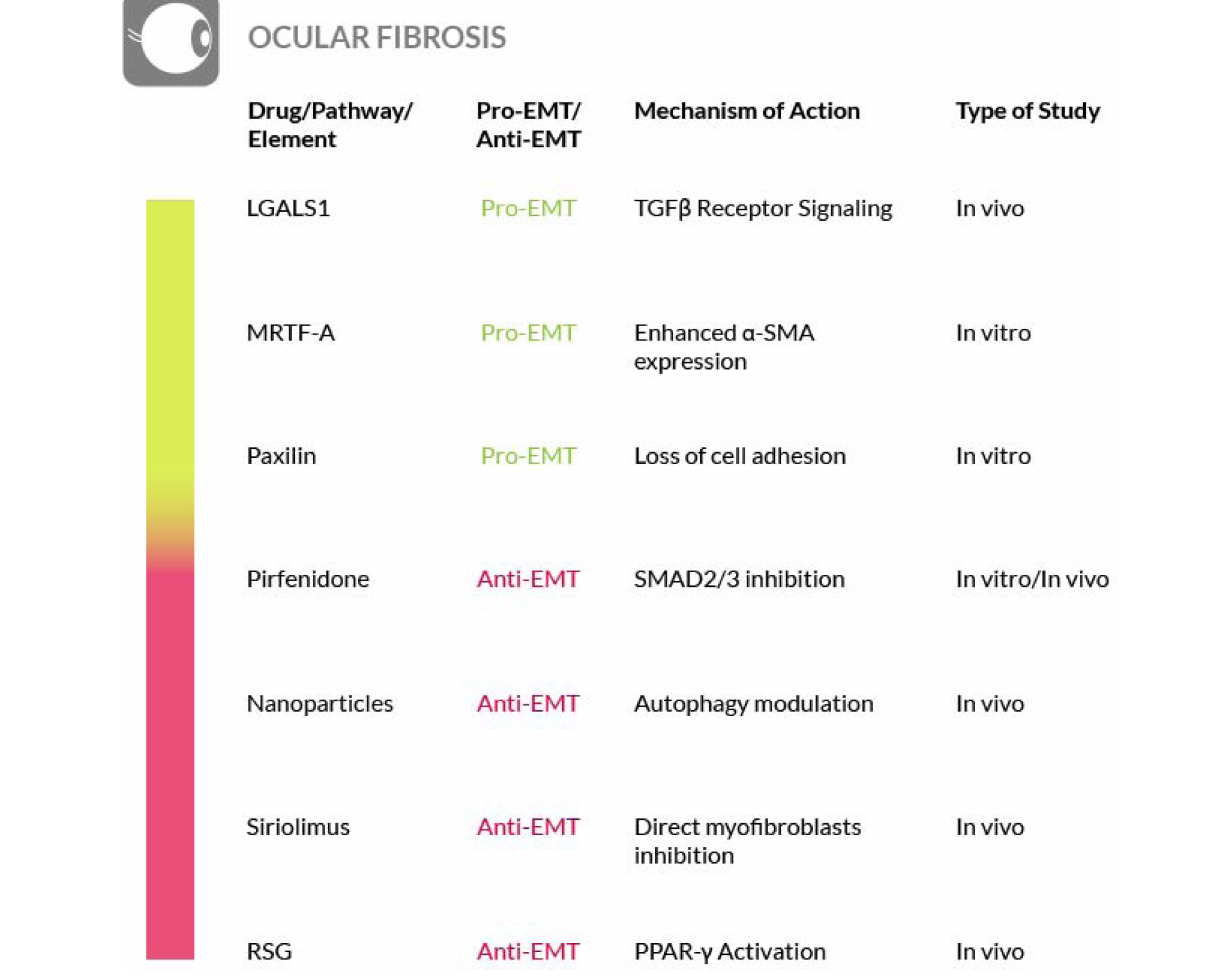
FIGURE 8 | Most relevant molecular mechanisms and possible drugs for the treatment of EMT in ocular